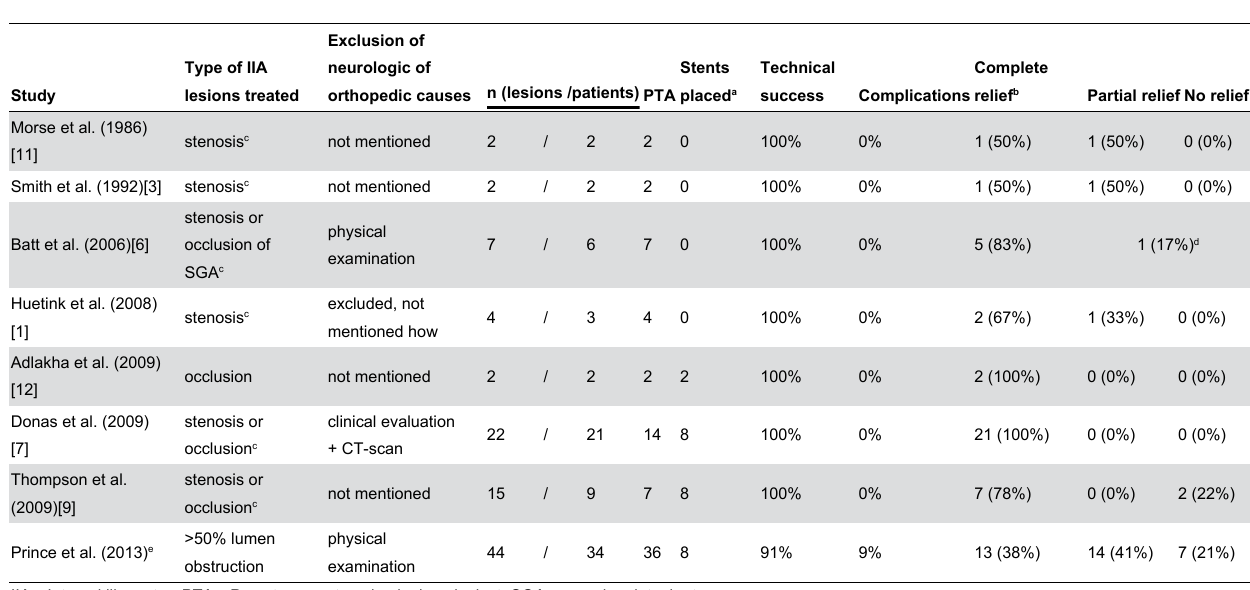
Table 4. Review of literature concerning endovascular therapy for IIA stenosis or occlusion.